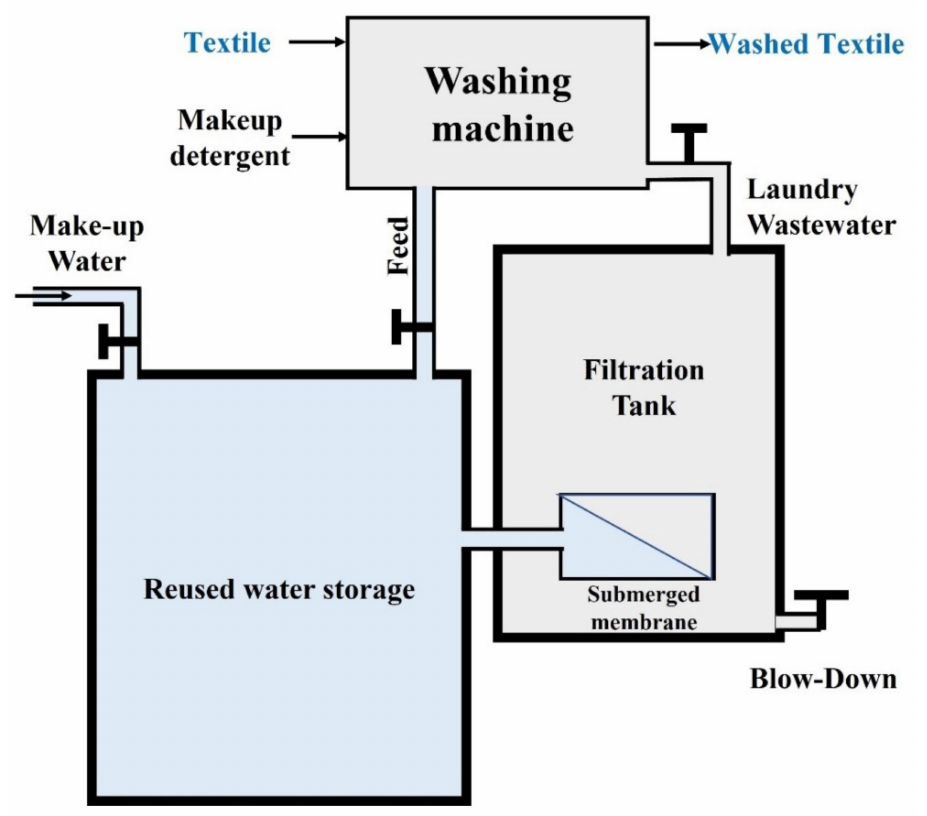
Figure 6. Practical implementation of reuse of laundry wastewater for laundry